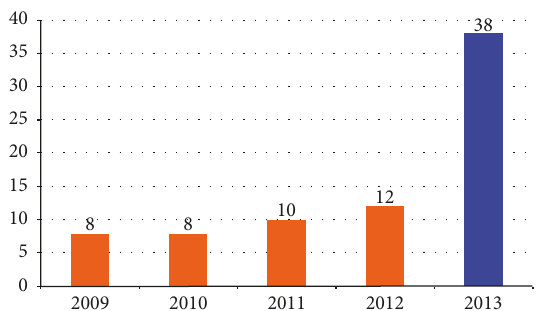
Figure 1: Distribution of detected micrometastases over the study period ( 𝑝 < 0.0001